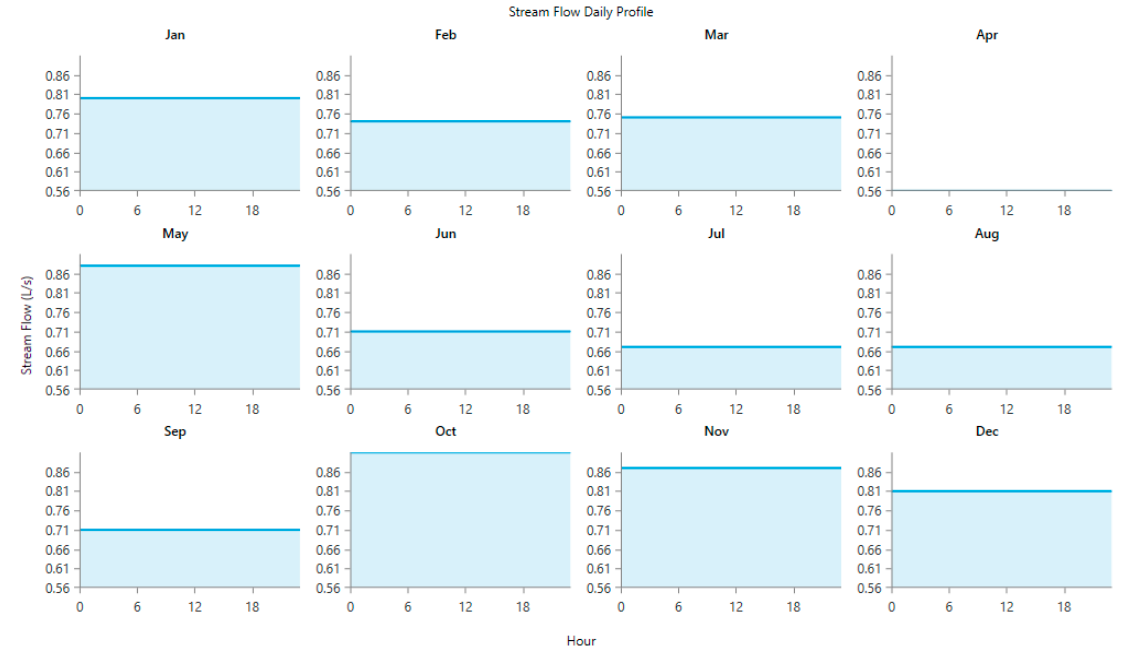
Figure 12. Average monthly stream flow rate for river Rushoma that supplies KHMG.